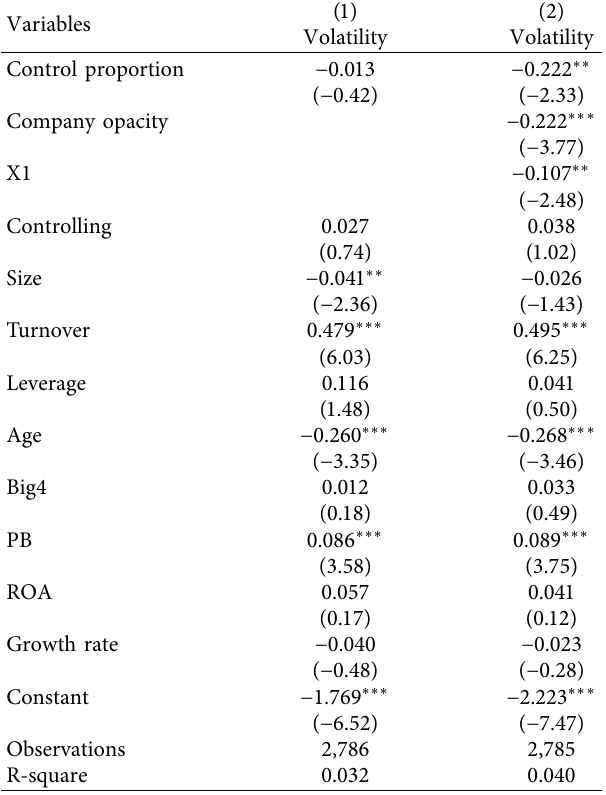
Table 5: Regression results